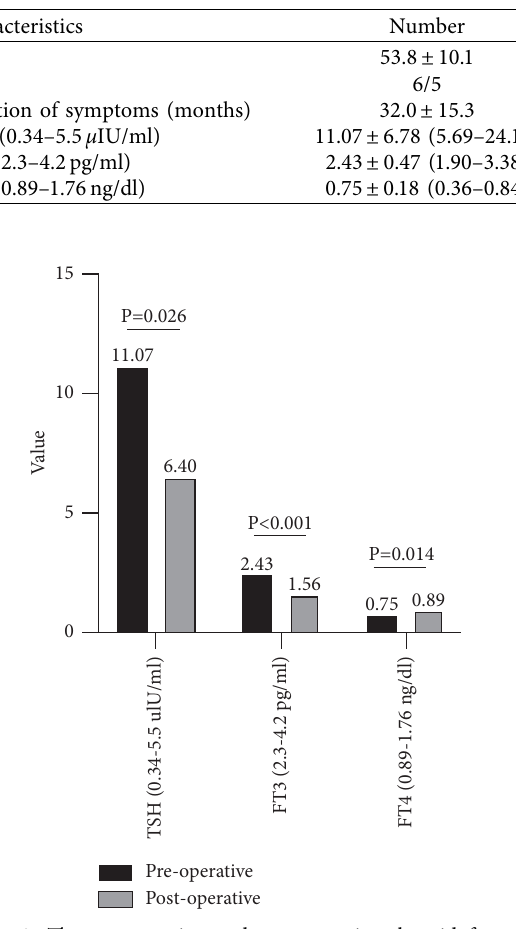
Figure 2: Te preoperative and postoperative thyroid function results of the 11 NFPA patients combined with primary hypothyroidism. Table 3: Te clinical information and preoperative thyroid function results of the two patients combined with primary hyperthyroidism.